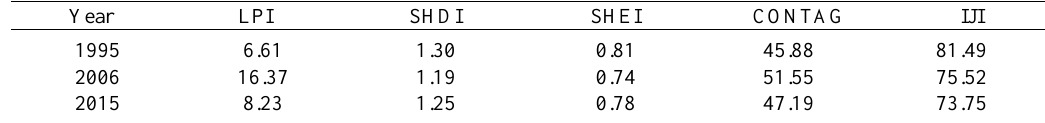
Table 4. Landscape index of land-cover in Dongting Lake